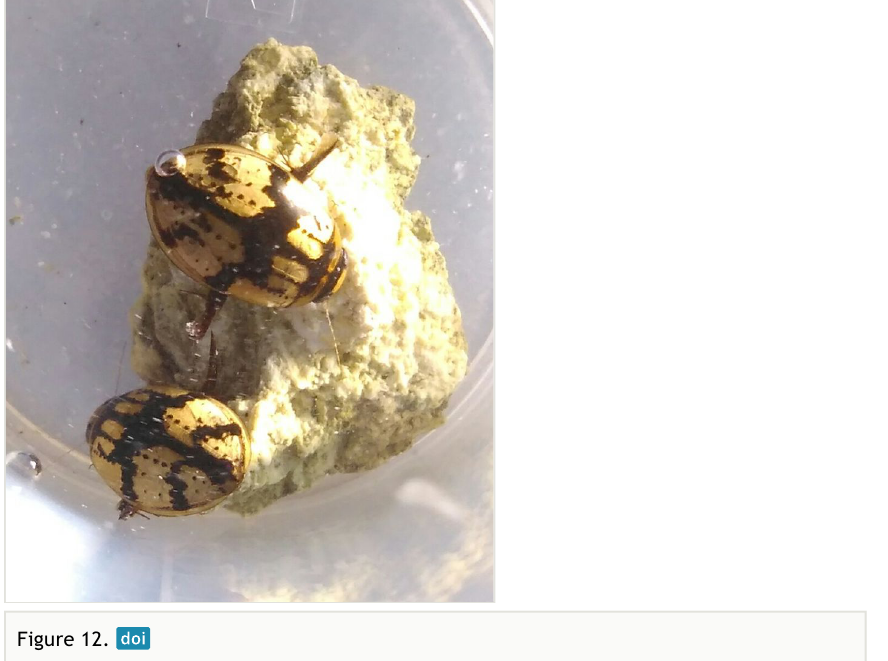
Figure 12. Sandracottus hunteri , HP image from